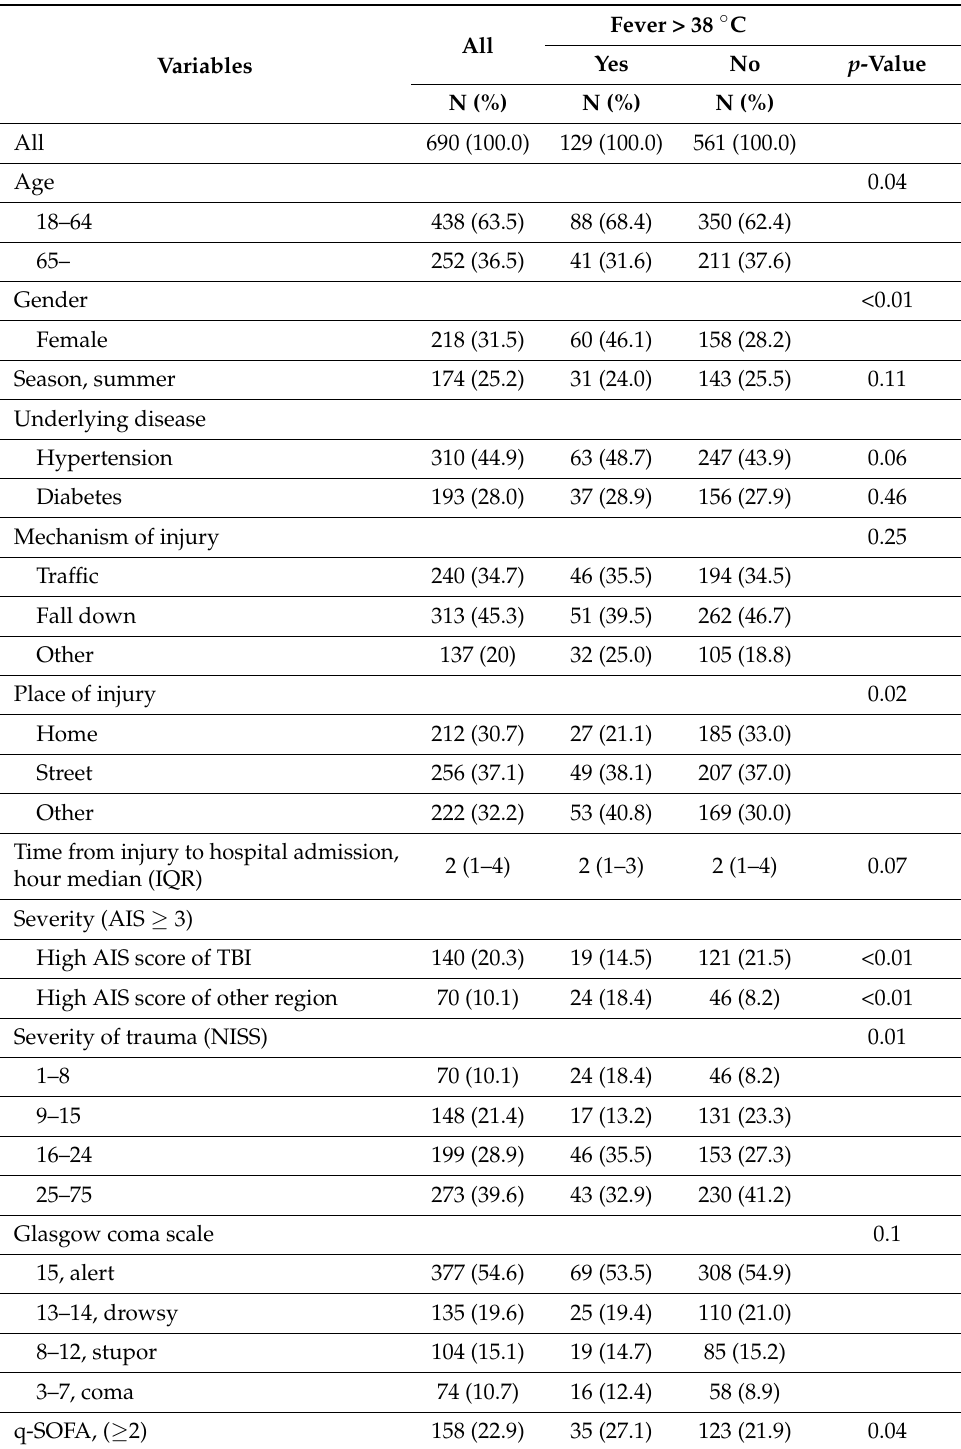
Table 1. Characteristics and clinical outcomes between traumatic brain injury patients with and without